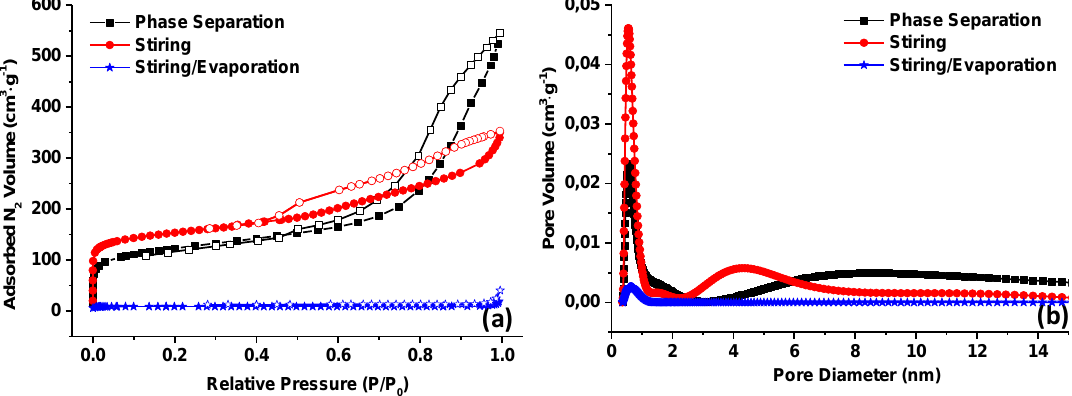
Figure 3. Nitrogen adsorption/desorption isotherms ( a ) and their corresponding 2D-NLDFT pore size distribution ( b ) of carbon materials obtained by using different synthesis procedures.